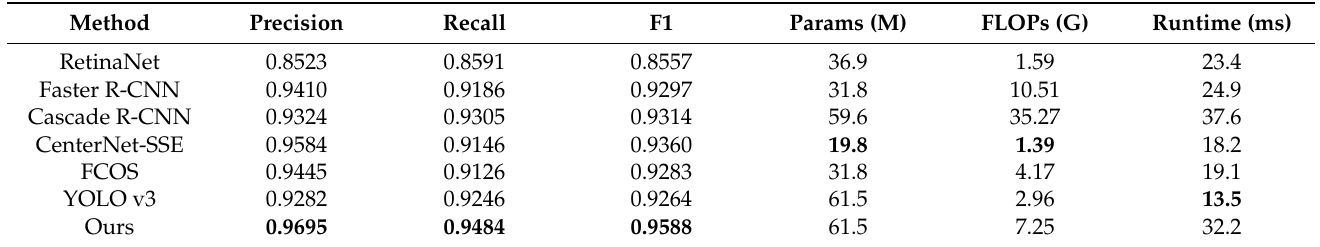
Table 10. Comparison results of CNN-based detectors on the SSDD dataset on other metrics.